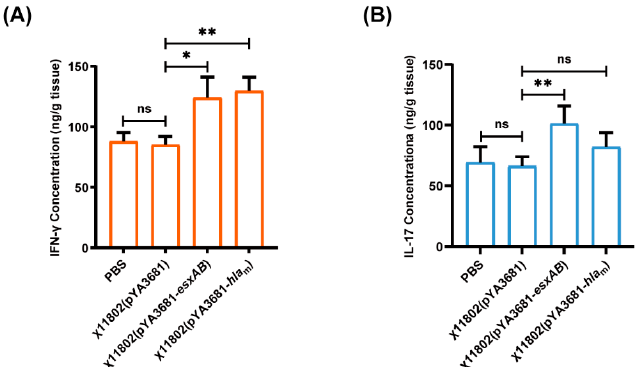
Figure 4. IFN- γ and IL-17 production in mouse kidney tissue elicited by oral administration with the recombinant strains of χ 11802. In ( A , B ), mice were orally administrated with PBS solution, χ 11802(pYA3681), χ 11802(pYA3681 − esxAB ), or χ 11802(pYA3681 − hla m ). ( A ) IFN- γ level in mouse kidney tissue. ( B ) IL-17 level in mouse kidney tissue. * p < 0.05; ** p < 0.01; ns, no significance.